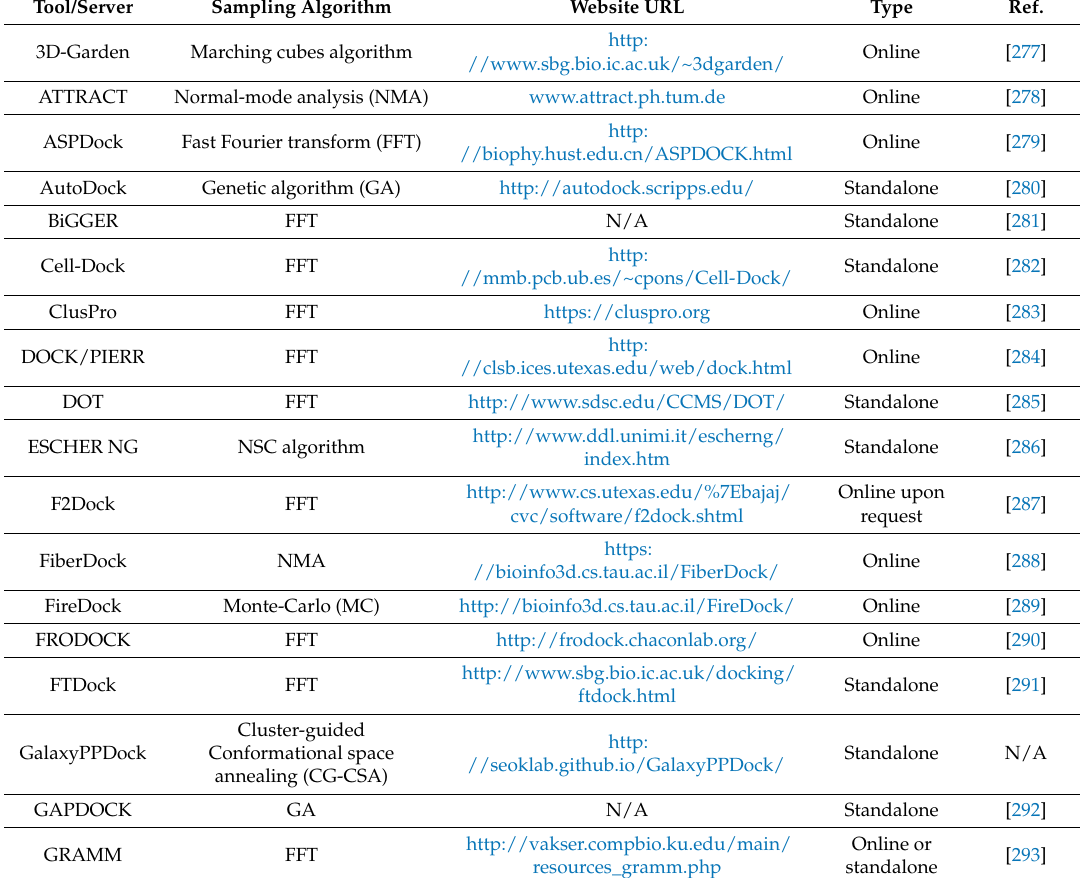
Table 4. Alphabetical listing of available protein-protein docking